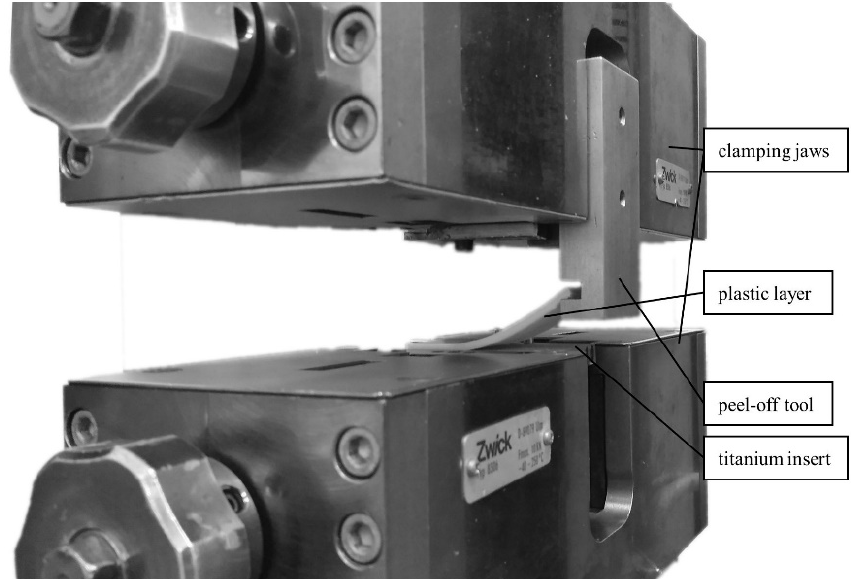
Figure 4. Overmoulded sample mounted in the universal testing machine using custom-built equipment.